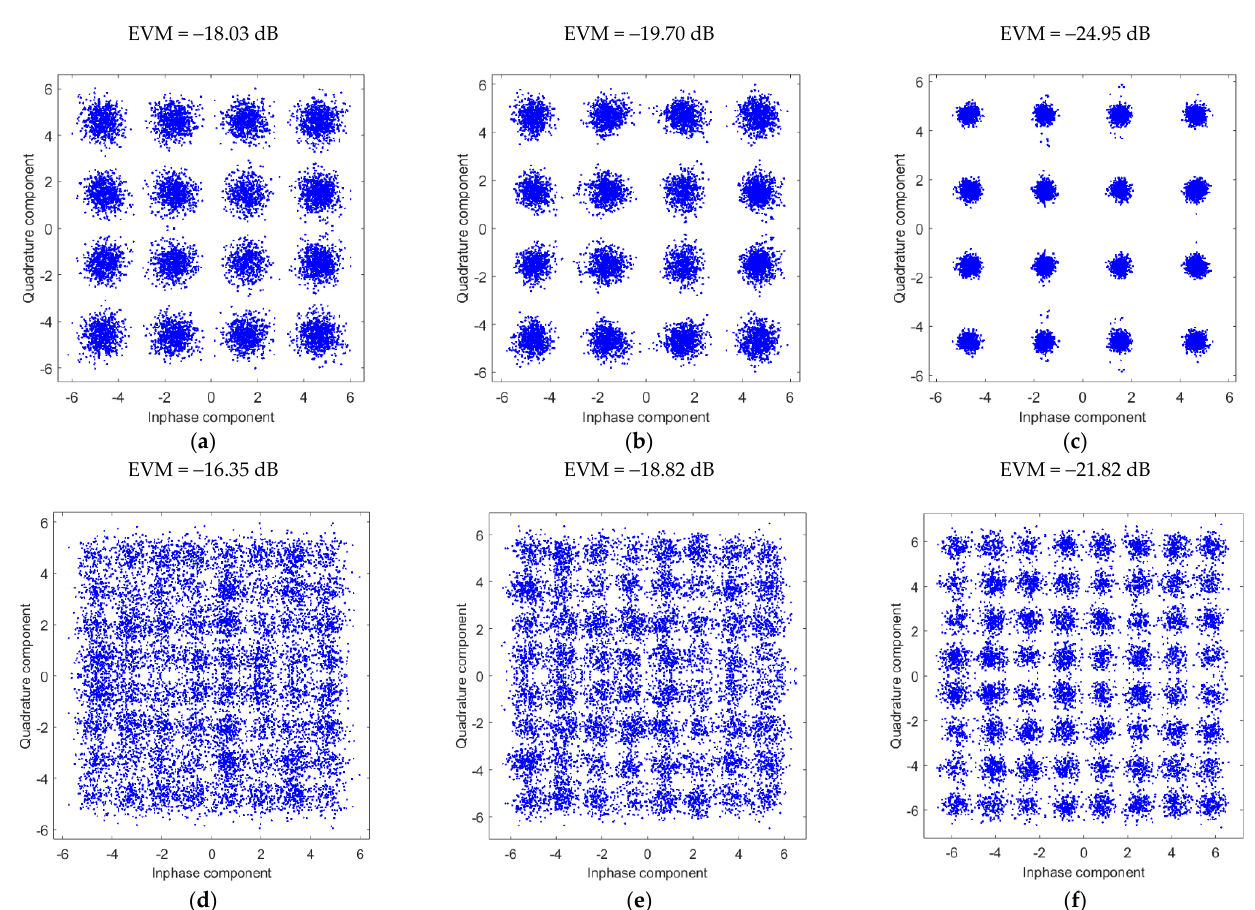
Figure 12. Constellation diagrams of 16 QAM and 64 QAM modulation. ( a – c ) are constellation diagrams of the 16 QAM modulated OFDM signal with the NLMS, Chebyshev polynomial, and the proposed ANN predistorters, respectively. ( d – f ) are constellation diagrams of the 64 QAM modulated OFDM signal with the NLMS, Chebyshev polynomial, and the proposed ANN predistorters, respectively.